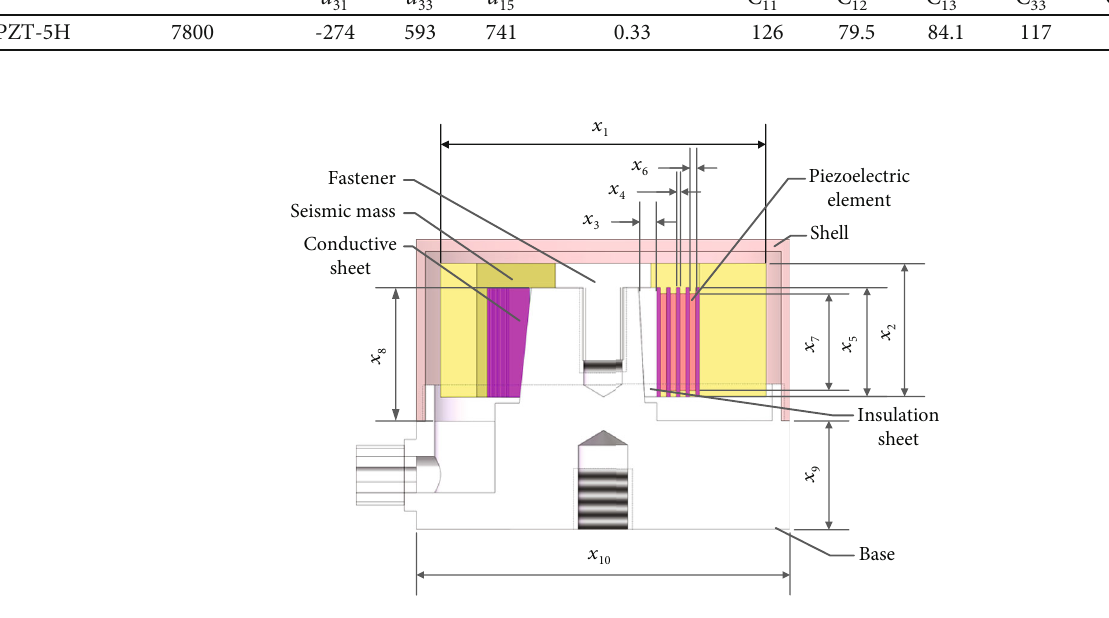
Figure 4: Ten design variables of numerical